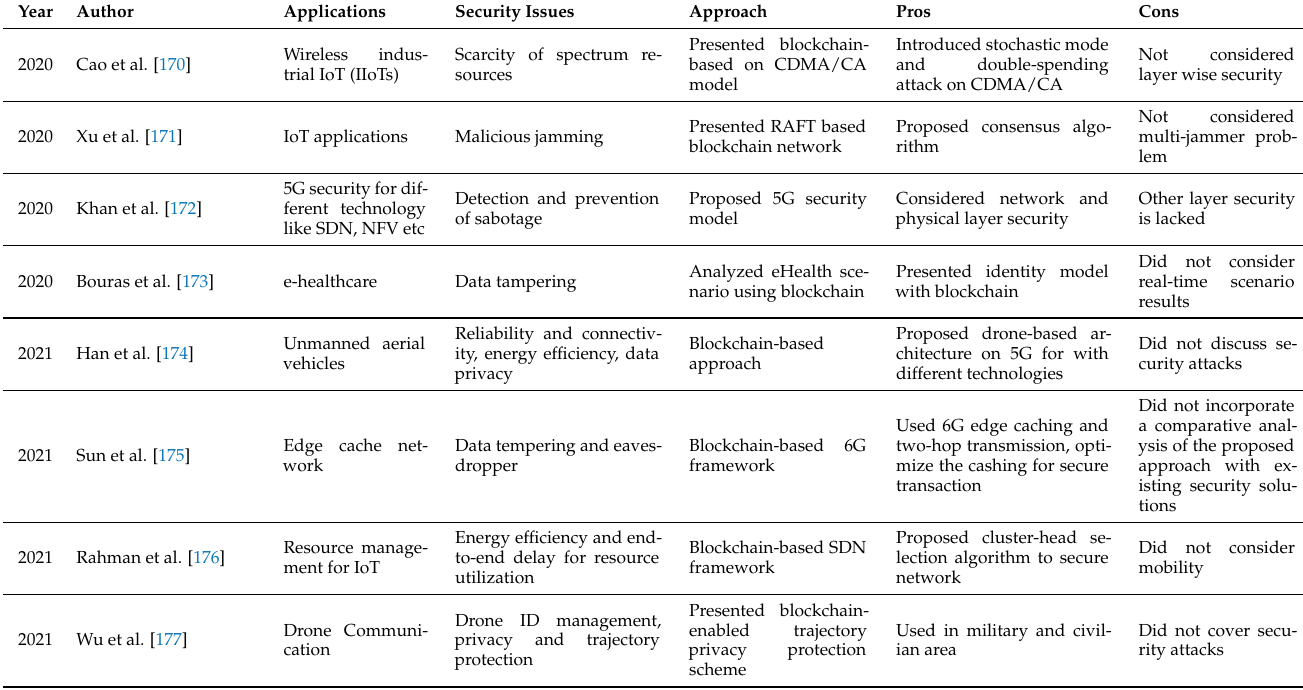
Table 3. Blockchain-based solution for different smart applications in security and privacy perspec- tives of